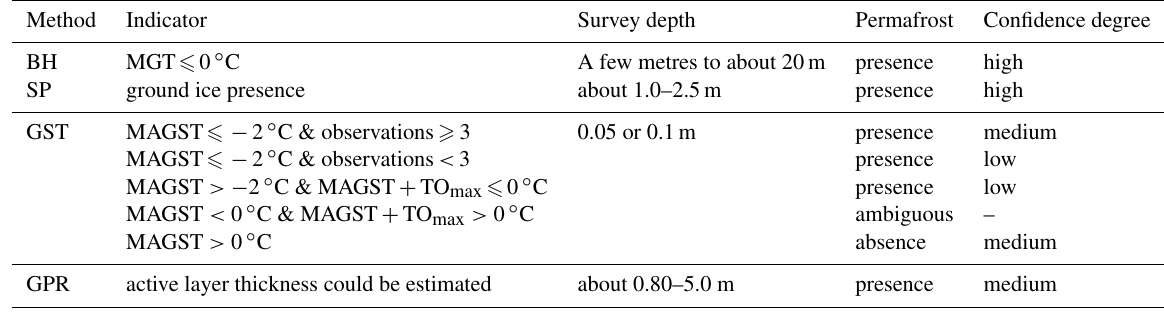
Table 1. Classification algorithm of evidence of in situ permafrost presence or absence from various methods.